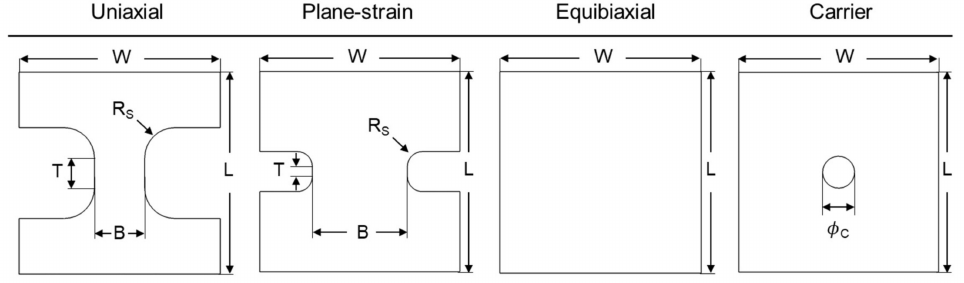
Figure 11. Geometries of the Marciniak specimens for all three strain paths and the carrier